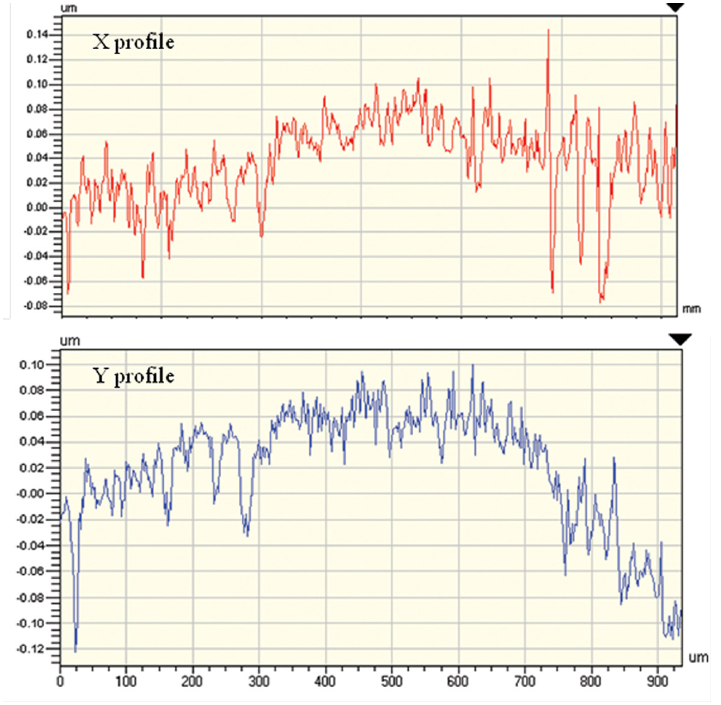
Figure 4. The roughness profiles of polished mild steel